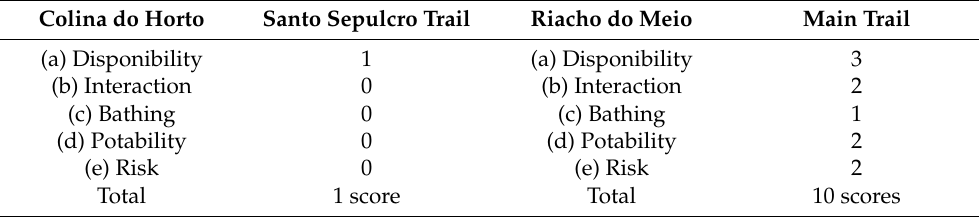
Table 2. Diversity and Aquatic interaction, Santo Sepulcro and Riacho do Meio trails.